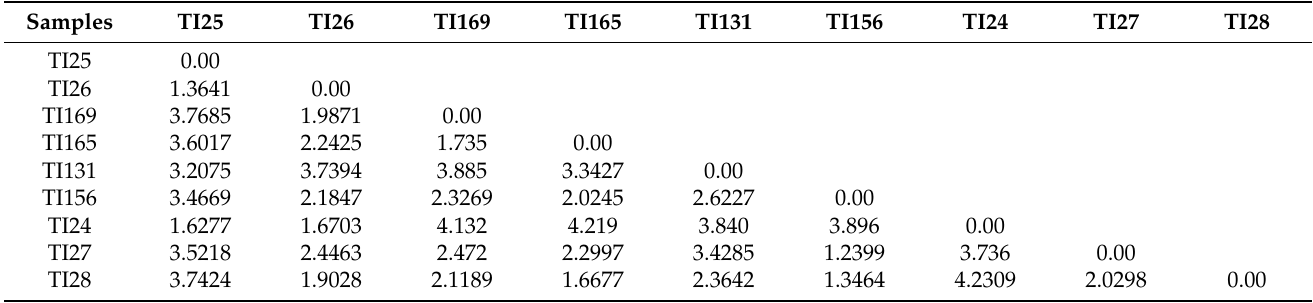
Table 2. Mahalanobis distances between T. infestans populations from different localities.